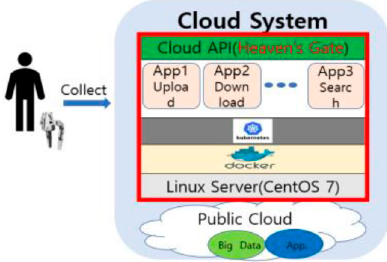
Figure 12. Schematic diagram of the cloud server [14].